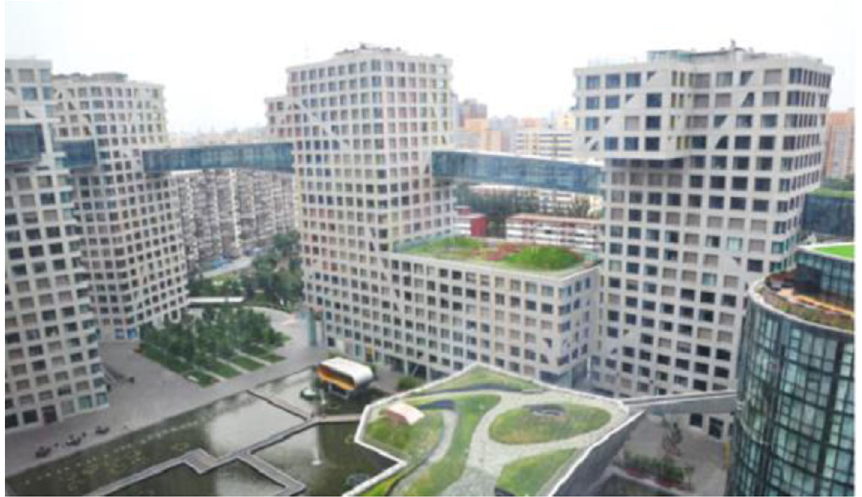
Fig. 16 Beijing contemporary world